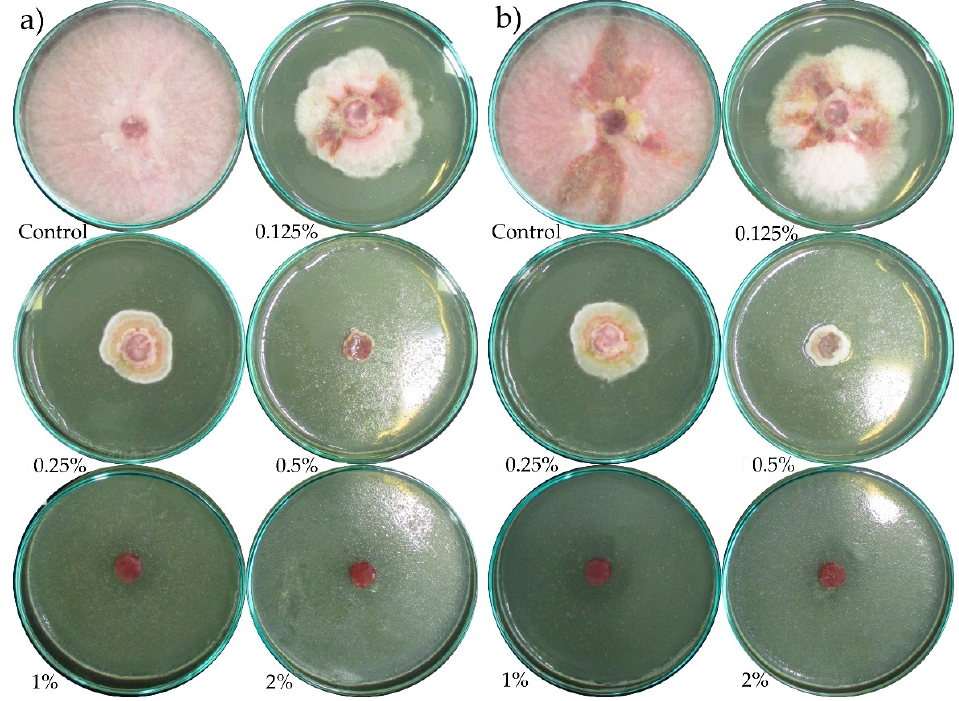
Figure A8. The effect of rosemary oil concentrations on the growth of Fusarium graminearum ZALF 24 ( a ) and Fusarium graminearum ZALF 339 ( b ).